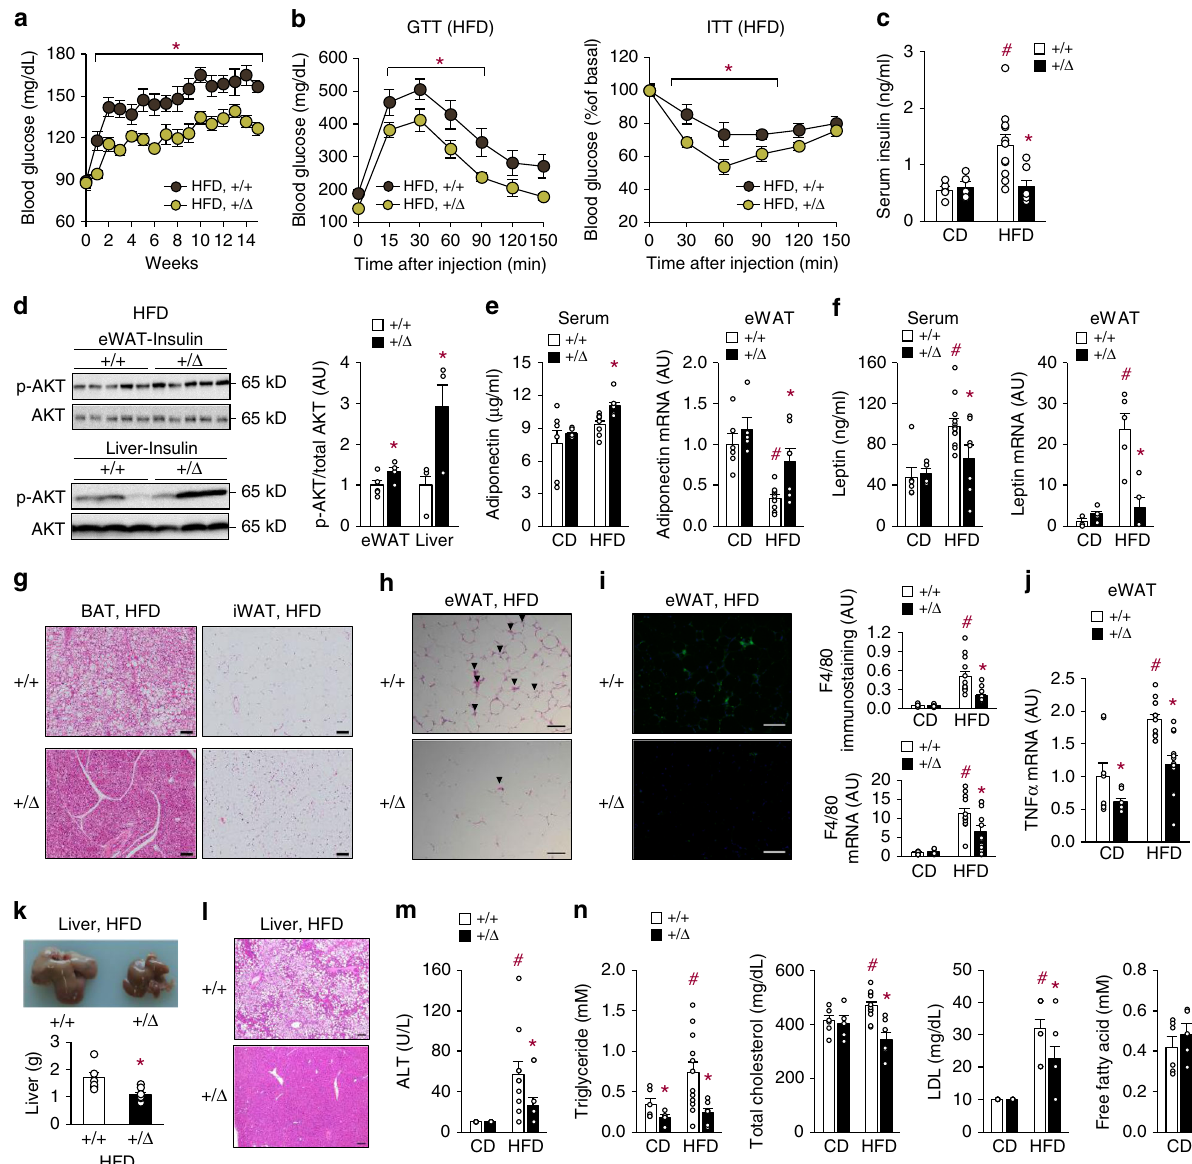
Fig. 3 TonEBP de fi ciency ameliorates obesity-induced insulin resistance and metabolic dysfunction. a Changes in fasting blood glucose levels after a switch to HFD ( + / + , n = 13; + / Δ , n = 11). b Glucose tolerance (left, n = 8) and insulin tolerance (right, n = 9) after 9 weeks on HFD. c – n Animals were analyzed after 16 weeks on HFD. c Circulating insulin concentrations (CD + / + , n = 5; CD + / Δ , n = 5; HFD + / + , n = 11; HFD + / Δ , n = 7). d Phosphorylation of AKT in